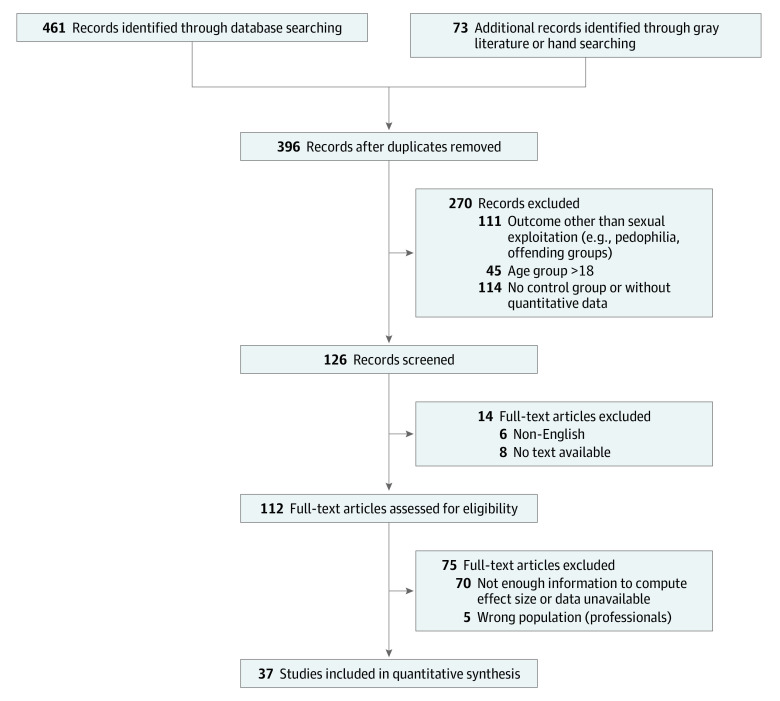
PRISMA Flow Diagram of Studies Included in the Systematic Review and Meta-analysis